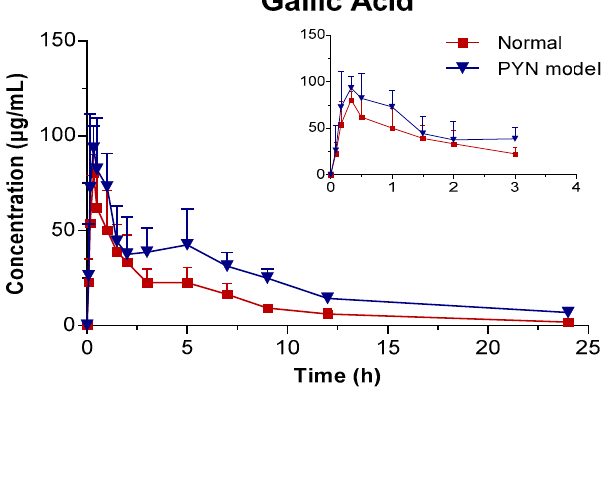
Table 4. Pharmacokinetic parameters of GA, PCA, and QR in rat plasma following the oral